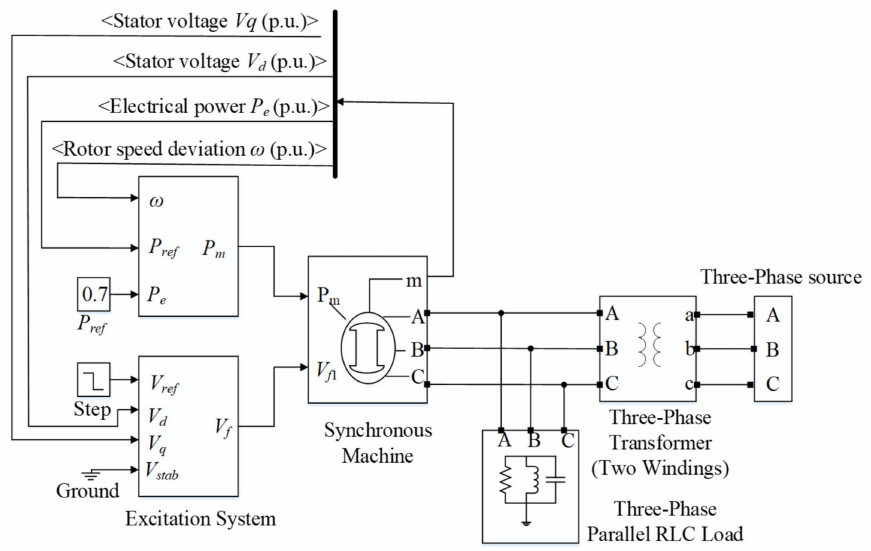
Figure 4. Model of the pumped storage power plant. V d and V q are the stator voltage of the d -axis and q -axis, respectively. Pe , Pm and P ref represent the electrical power, the power output of the hydro turbine per unit and the reference output, respectively. V ref , V stab and V f are the reference value of the stator terminal voltage, the voltage connected to a power system stabilizer and the field voltage, respectively. A, B and C stand for the stator voltage input/output terminal. a, b and c denote the winding rotor output voltage terminal. dw is the rotor speed